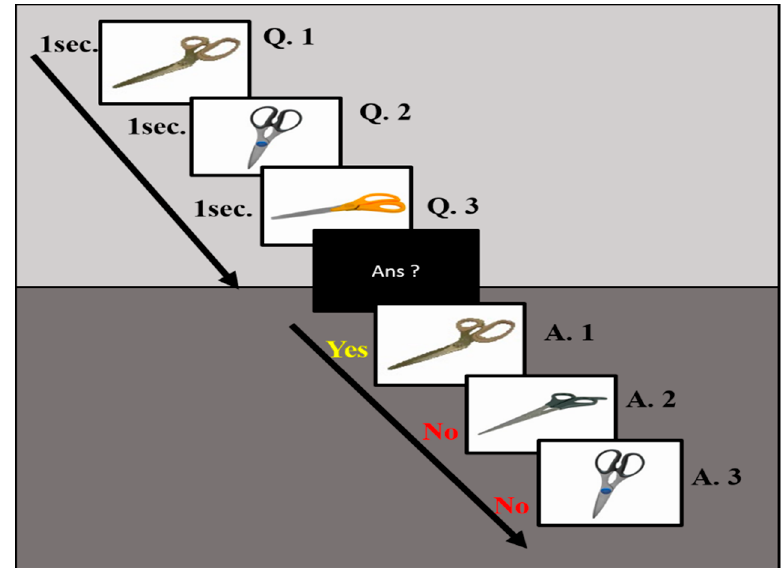
Figure 2. The demonstration of working memory images was used to recognize the state of human mental focus. In the working memory task, a sequence of images was presented one by one on a computer screen. The duration of each image appeared was 1 s. Each subject was instructed to memorize images in the correct order. The three images were presented as question memory images, three other images were used as the response image. This sequence was presented repeatedly. All participants were instructed to identify the correct image in the work memory